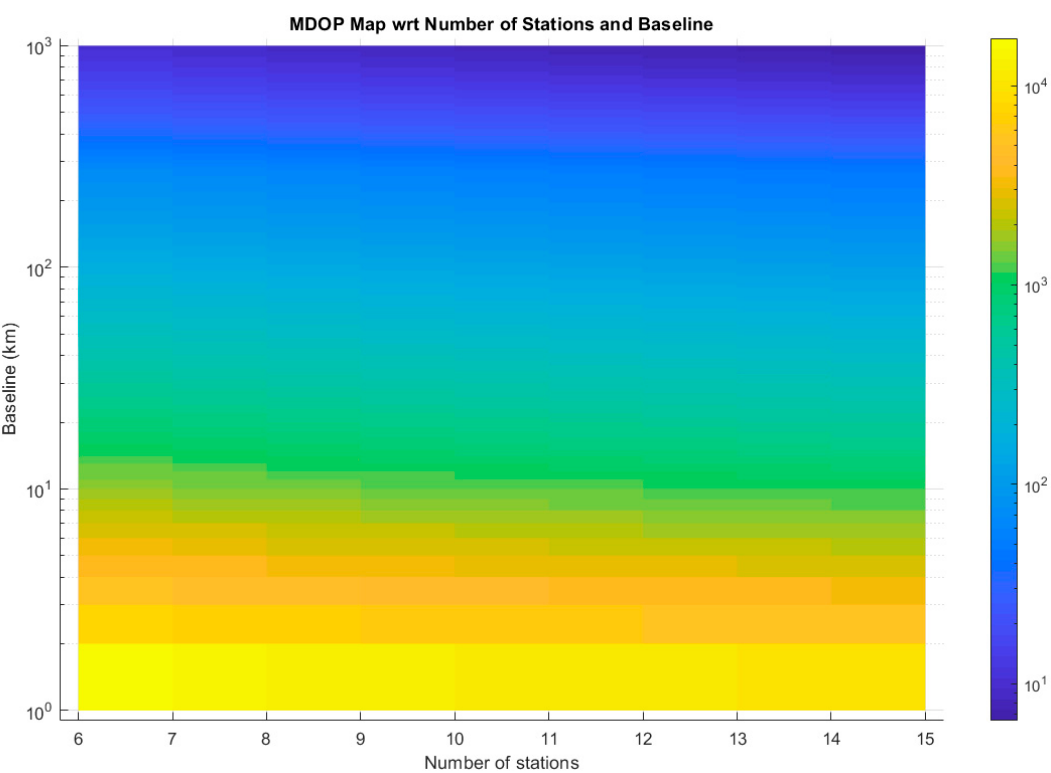
Figure 10. MDOP value with respect to number of stations and baseline.